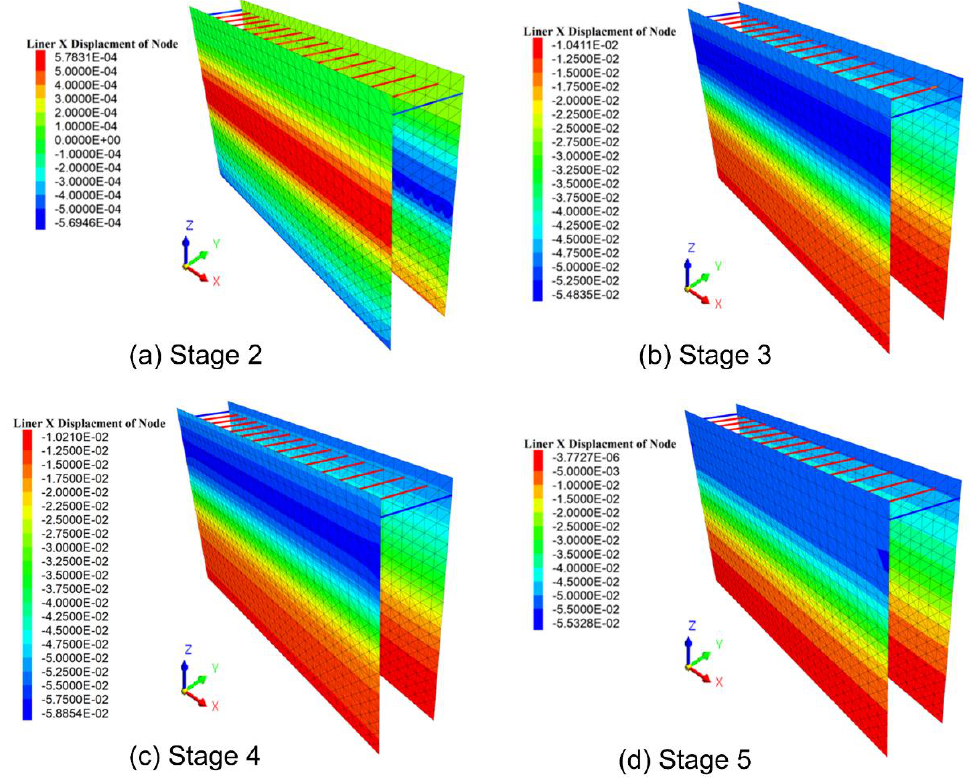
Figure 9. Horizontal displacement contours of piles at different stages (unit: m).